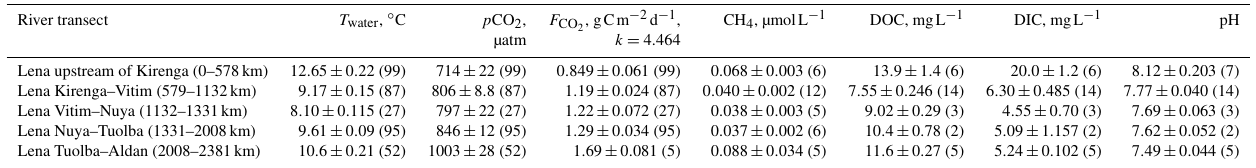
Table 1. Measured water temperature, p CO 2 , calculated CO 2 flux, CH 4 , DOC, and DIC concentrations and pH in the Lena River main stem (average ± SD; ( n ) is number of measurements).